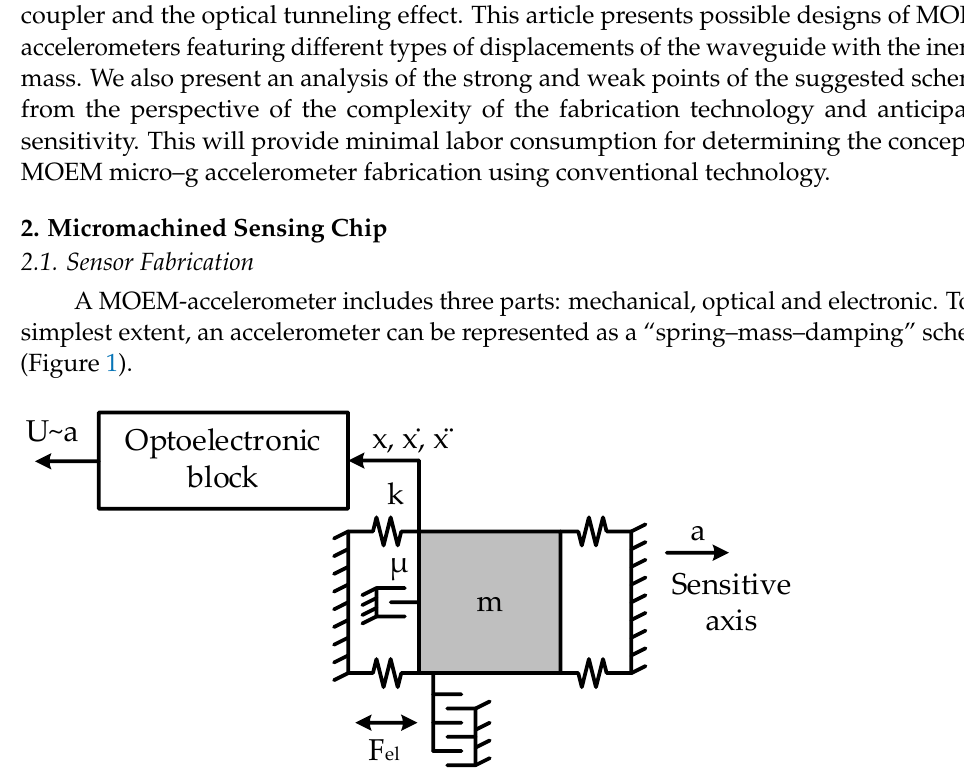
Figure 1. Functional scheme of an accelerometer.